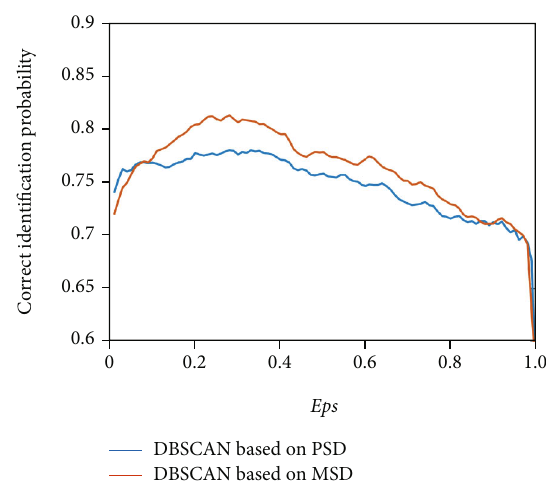
Figure 16: Correct identi fi cation probability under di ff erent Eps